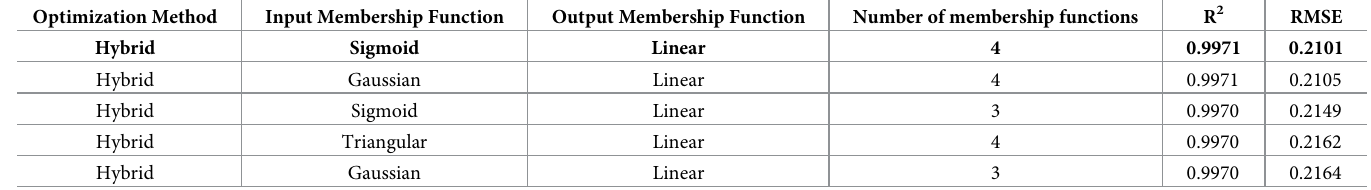
Table 11. Performance criteria of the five most accurate ANFIS structures trained with 2021 data for LA estimation. Optimization